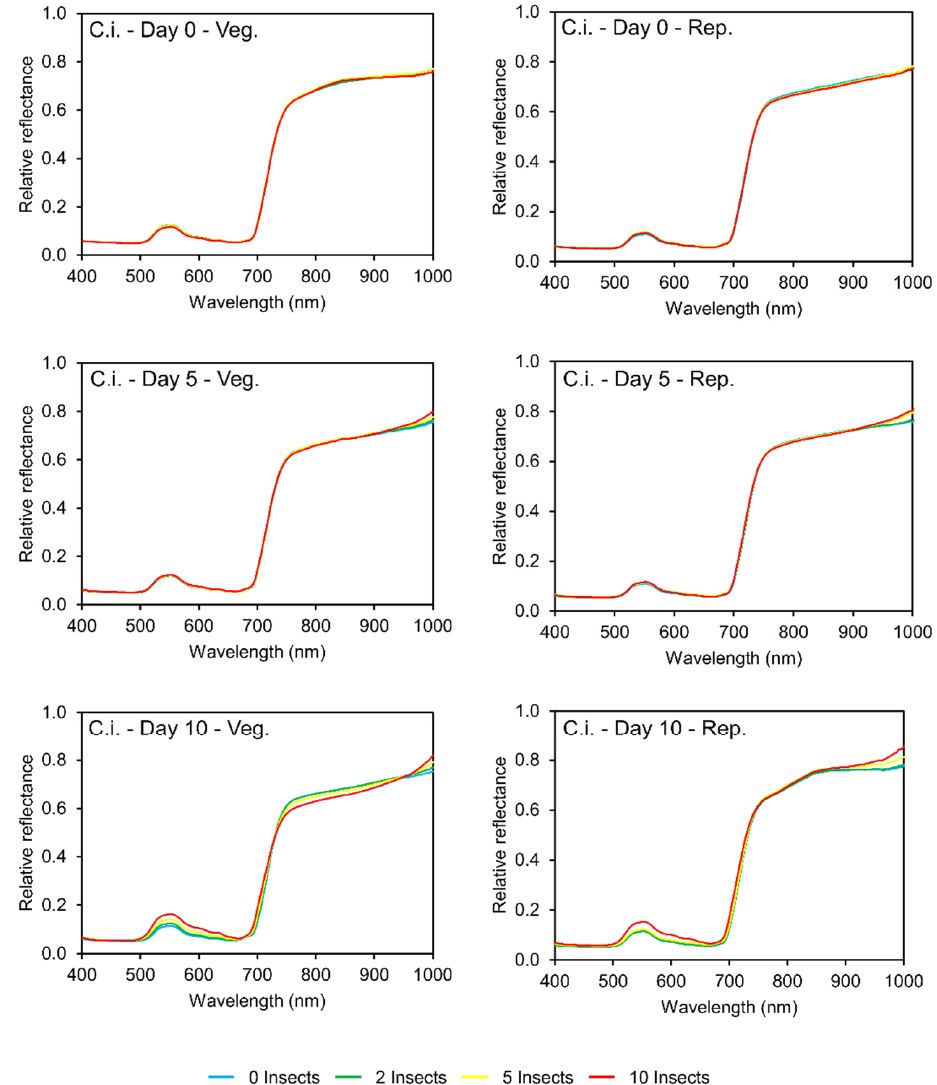
Figure 3. Spectral curves (400–1000 nm) of soybean leaves (0, 5, and 10 days after infestation) from plants under different levels of Chrysodeixis includens (C.i.) infestation ( left column —soybean vegetative period; right column —soybean reproductive period).